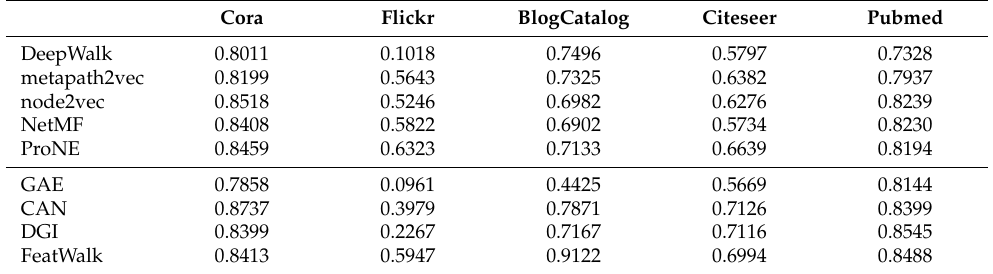
Table 12. Results in Task 3 using TPE to tune hyperparameters, in terms of macro-averaged F1. Cora